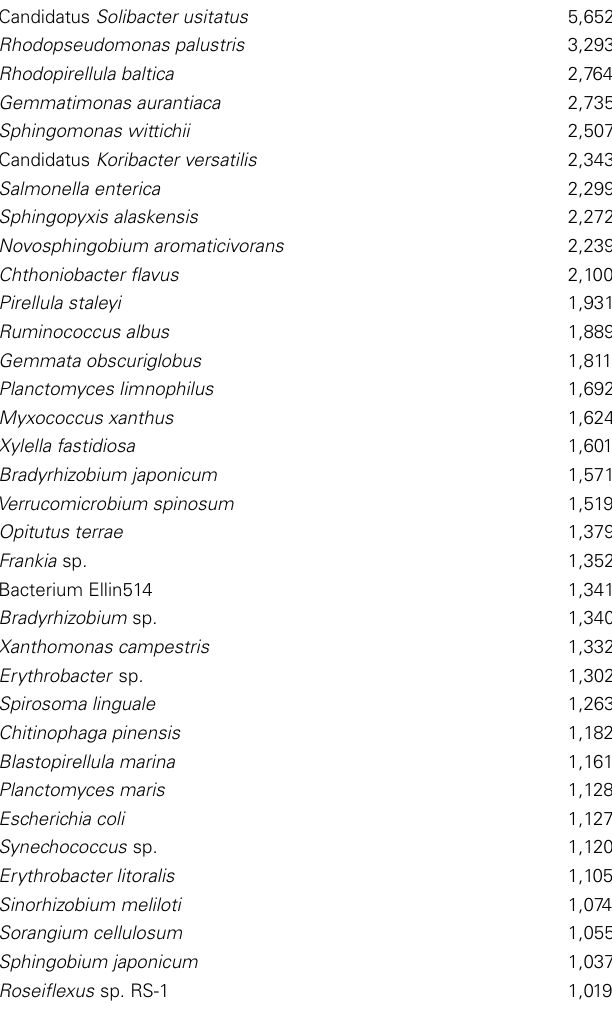
Table 3 | Phylogeny of bacterial sequences derived from 454 pyrosequencing data, with number of sequences in each group (where frequency >